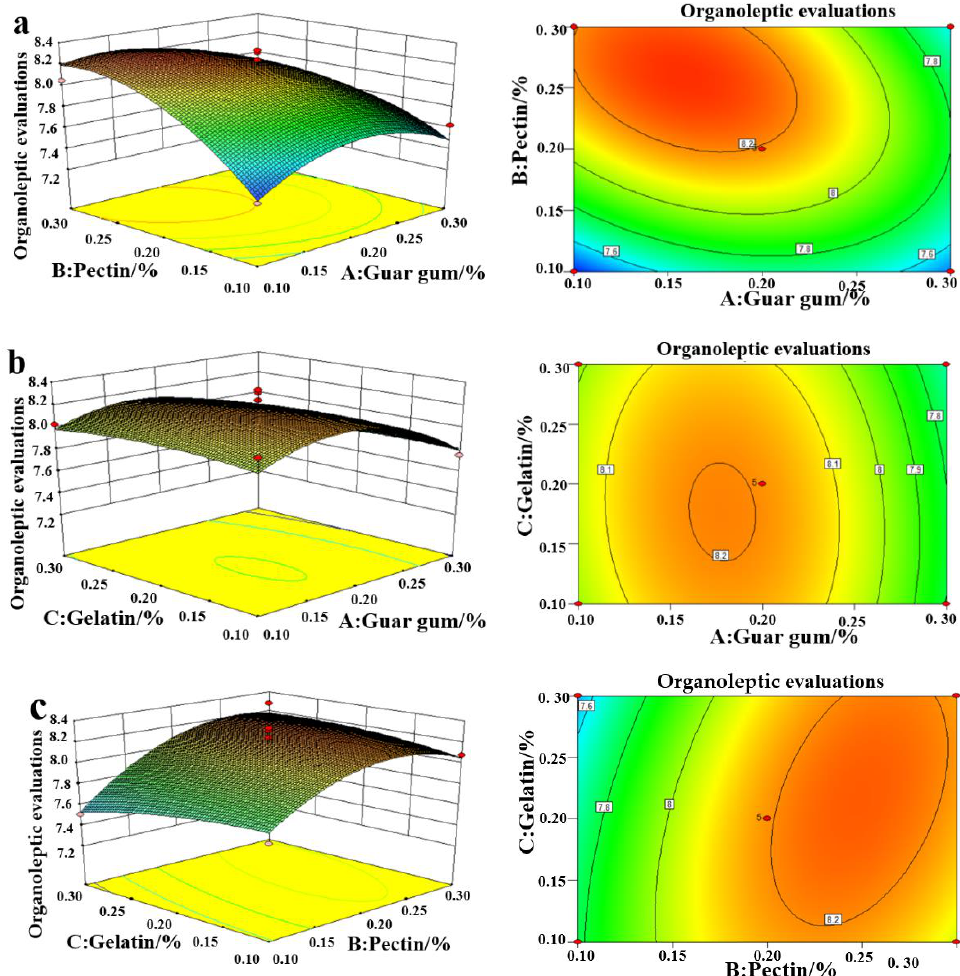
Figure 3. Response surface methodology of the interaction between guar gum and pectin ( a ), guar gum and gelatin ( b ), and pectin and gelatin ( c ) to organoleptic evaluations.